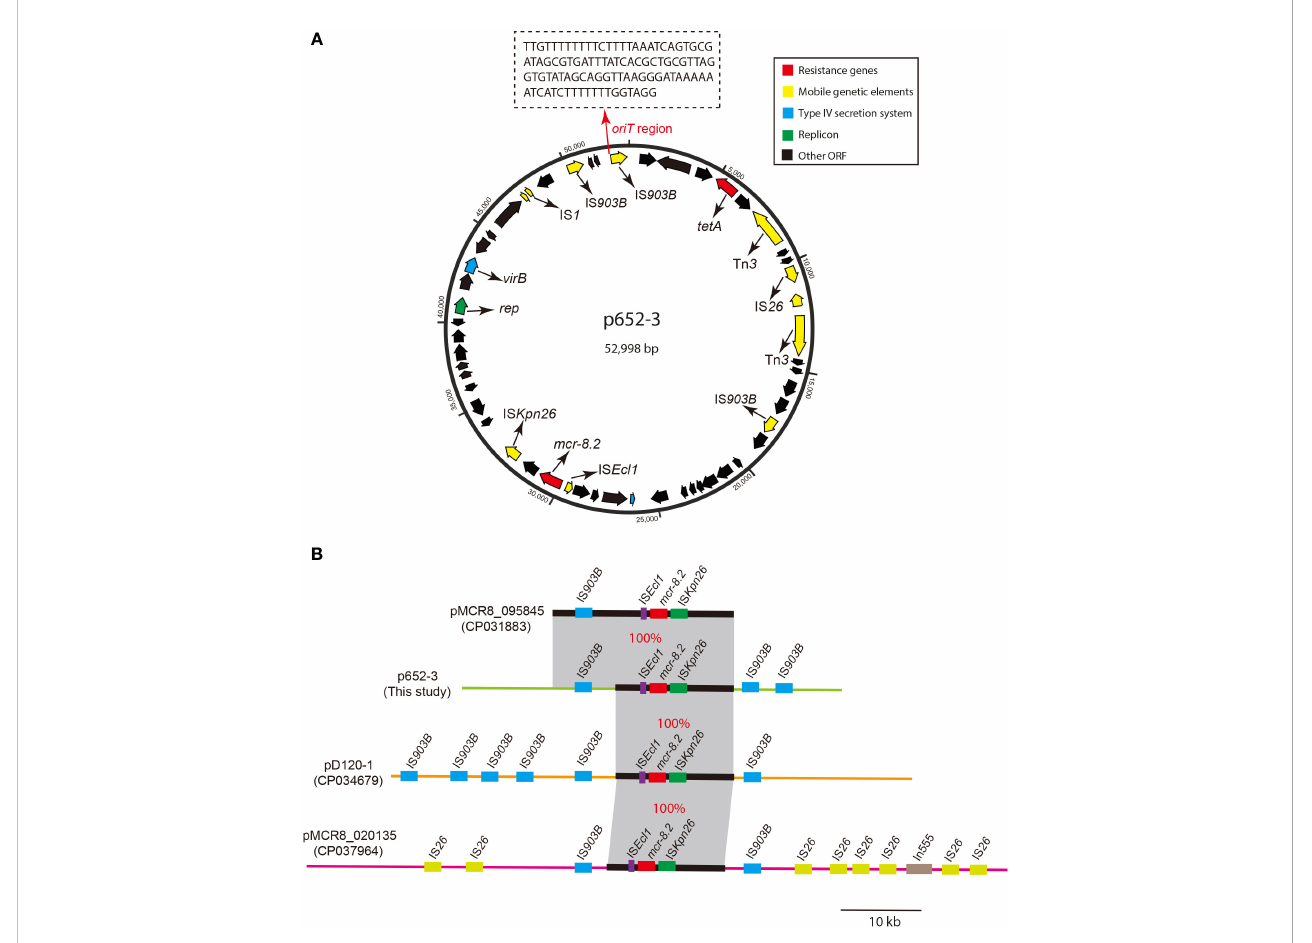
FIGURE 3 Circular map of plasmid p652-3 harboring mcr-8.2 and plasmid comparison with pMCR8_095845, pD120-1 and pMCR8_020135. (A) Circular map of the p652-3 plasmid. Replicon (green), antimicrobial resistance genes (red), IS elements (yellow), T4SS (blue) and other ORFs (black) are shown. Another thin red arrow indicates the oriT region for the origin of transfer. (B) Linear structure of the p652-3 plasmid compared with pMCR8_095845 (CP031883), pD120-1 (CP034679) and pMCR8_020135 (CP037964). Near 100% identical sequences are bridged by gray shading. Red fi lled boxes indicate mcr-8.2 genes. Blue, green, and purple fi lled boxes represent IS 903B , IS Kpn26 and IS Ecl1 , respectively. Eight IS 26 copies are also shown in pMCR8_020135 in light